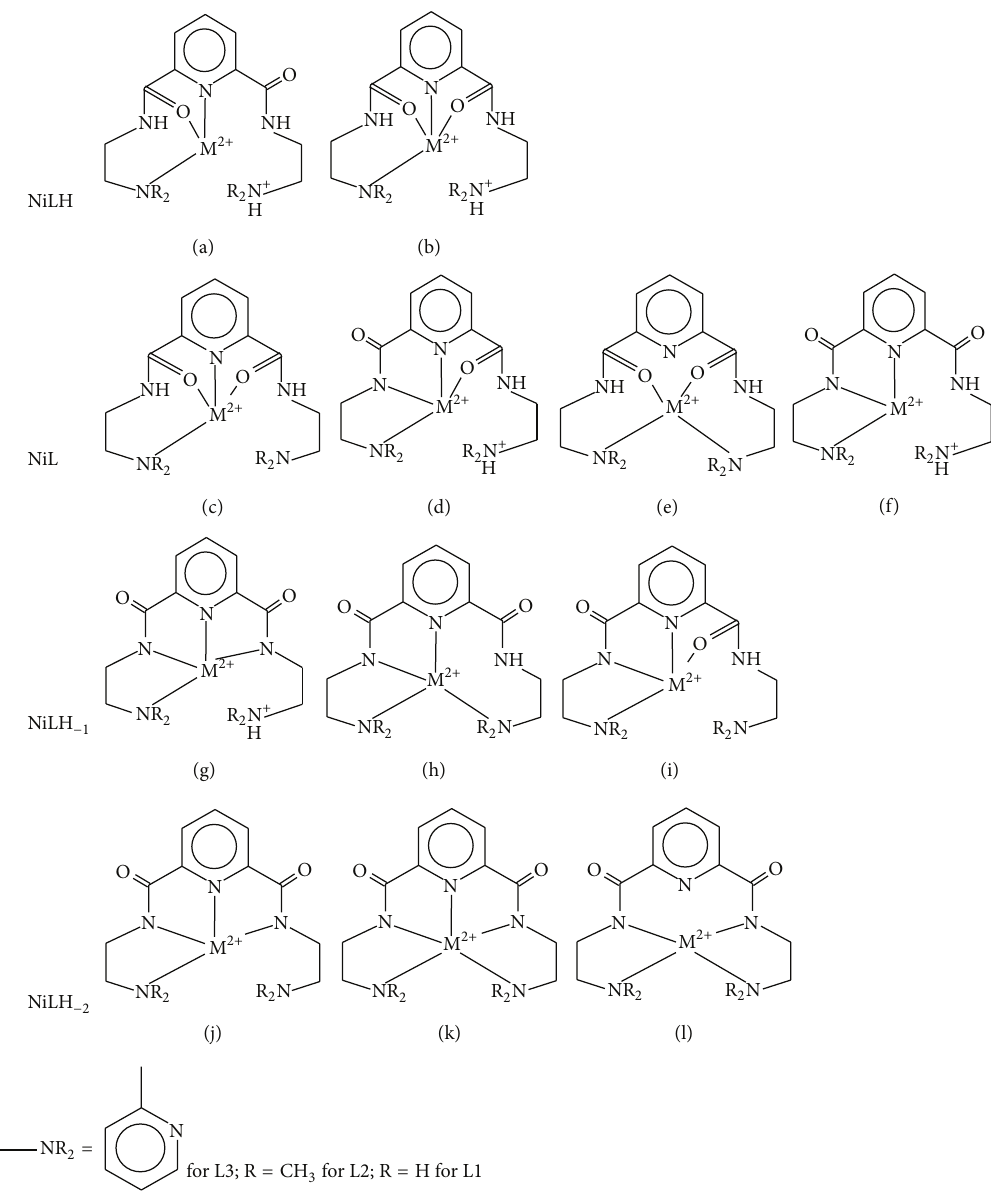
Figure 4: Schematic representation of proposed structures of the various Nickel-ligand